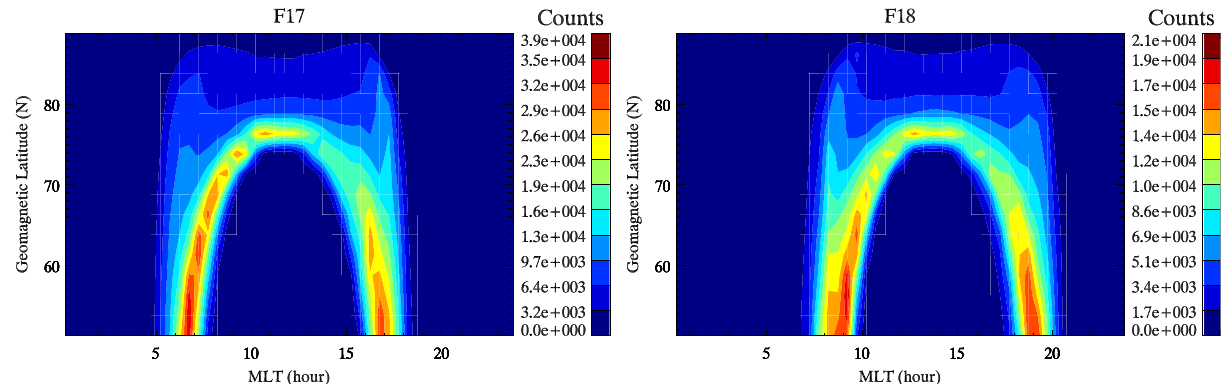
Fig. 1. Distribution of DMSP F17 (left) and F18 (right) data with respect to Geomagnetic Latitude and Magnetic Local Time (MLT). For the purpose of these statistics, bins sizes were 0.25 h in MLT and 2.5 (cid:1) in geomagnetic latitude.